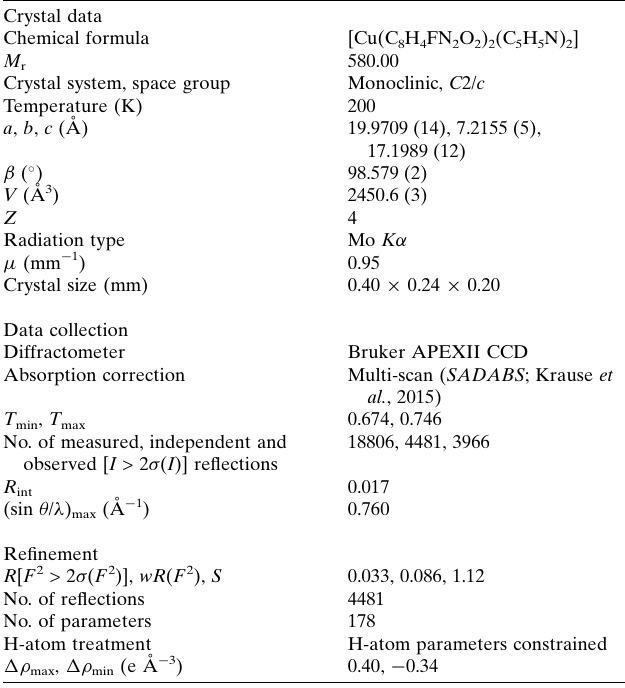
Table 2 Experimental